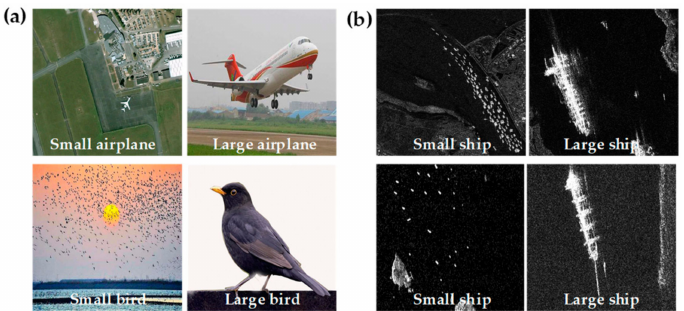
Figure 10. Small targets and large targets in the deep learning community. ( a ) Small objects and large objects in the nature; ( b ) small ships and large ships in the SAR images.